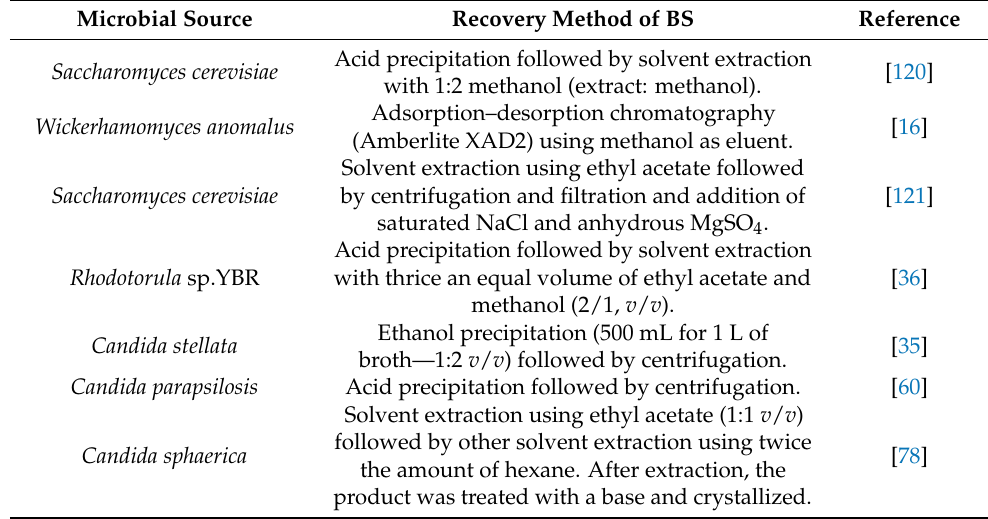
Table 3. The latest techniques for recovering biosurfactants from the fermentation broth produced by